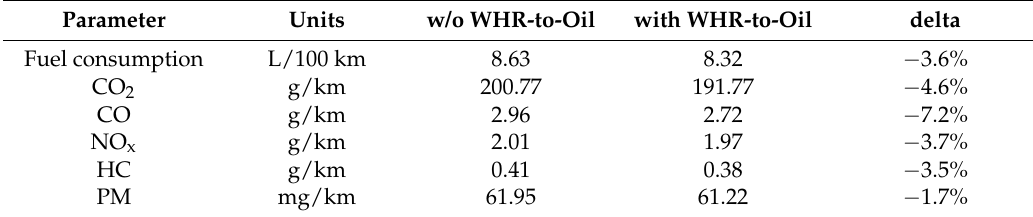
Table 3. Fuel consumption and emissions results with and without exhaust heat recovery to